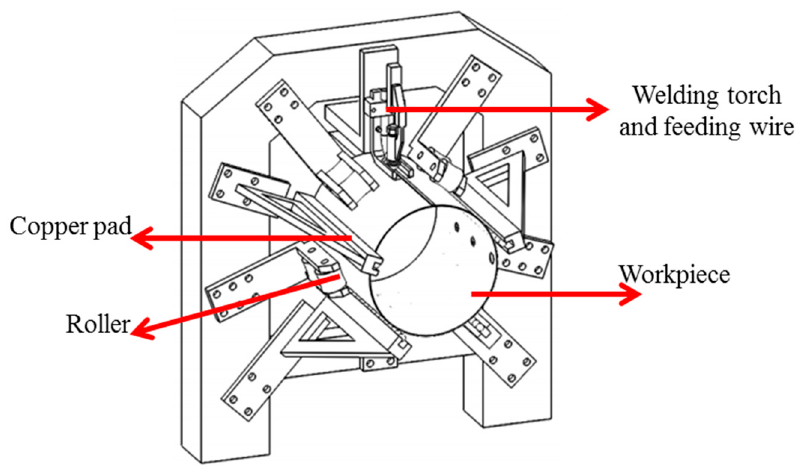
Figure 1. Plasma welding system isometric drawing. Table 5. Welding parameters of Plasma Arc Welding (PAW) for longitudinal weld.